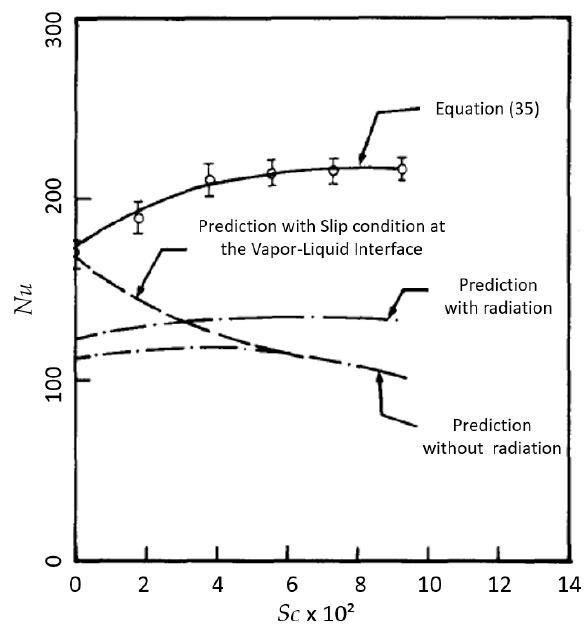
Figure 16. Data and models for natural convection heat transfer (represented by Nu (Y-axis)) as a function of the coolant subcooling (represented by Sc (X-axis)) for 19-mm diameter Cu, Ag, and stainless steel spheres (adapted from Reference [83]).